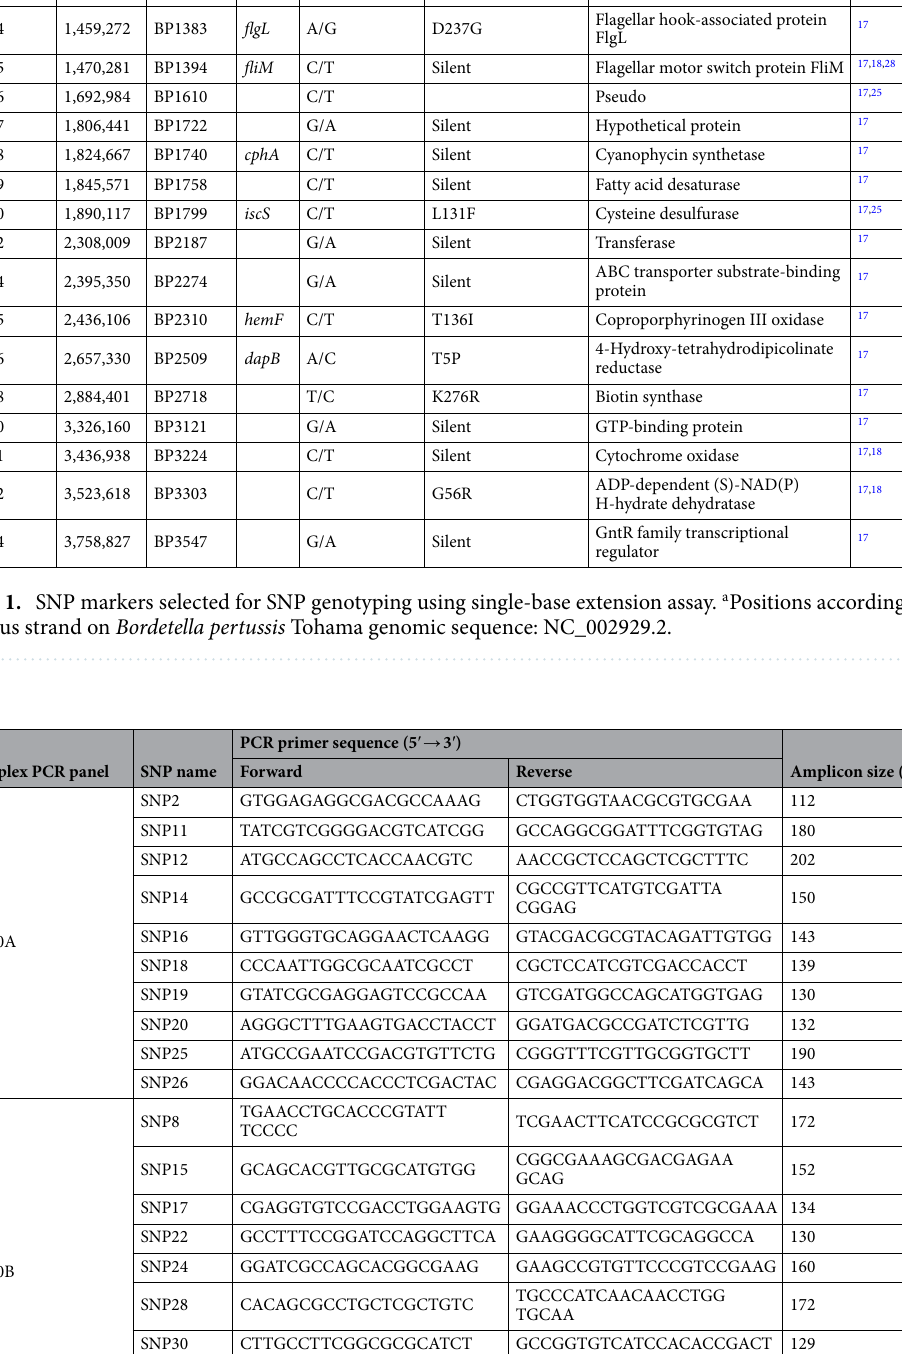
Table 2. PCR primers used for the multiple PCR panels, SNP20A and SNP20B.